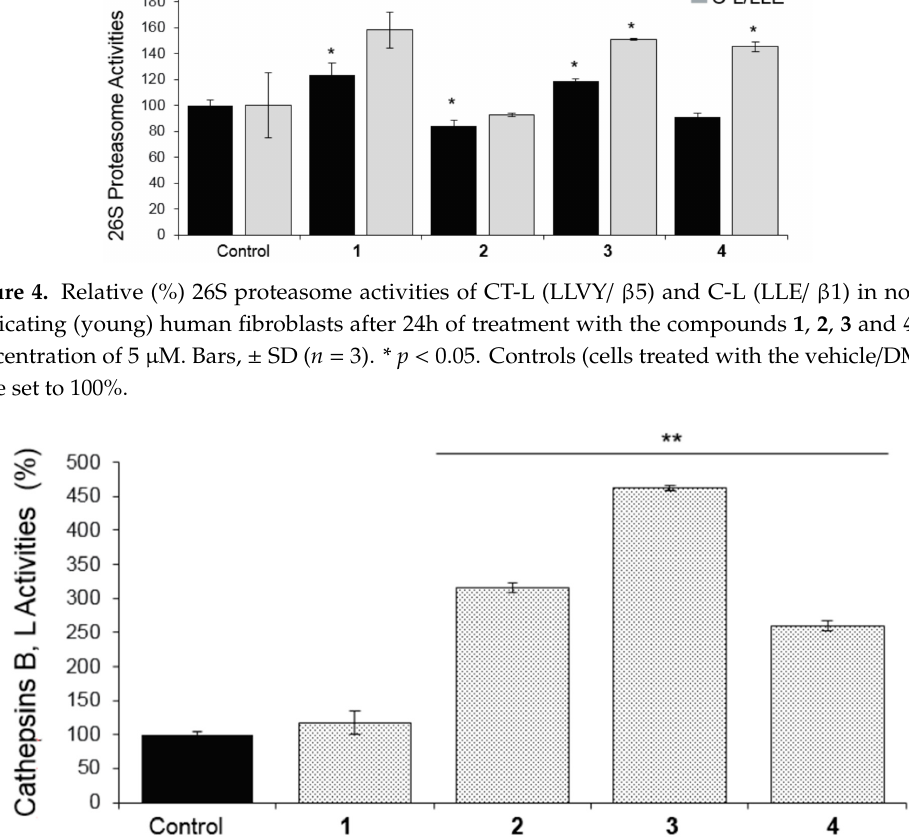
Figure 5. Relative (%) cathepsins B and L activities in normal replicating (young) human fibroblasts after 24 h of treatment with the compounds 1 , 2 , 3 and 4 at a concentration of 5 µ M. Bars, ± SD ( n = 3). ** p < 0.01. Controls (cells treated with the vehicle / DMSO) were set to